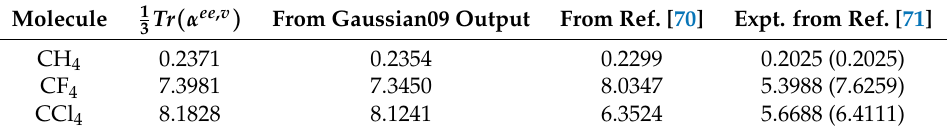
Table 1. Vibrational electric polarizabilities of CH 4 , CF 4 , and CCl 4 (data are in atomic units [41]; B3LYP/aug-cc-pVTZ DFT calculations for Columns 1 and 2—present work). The minor